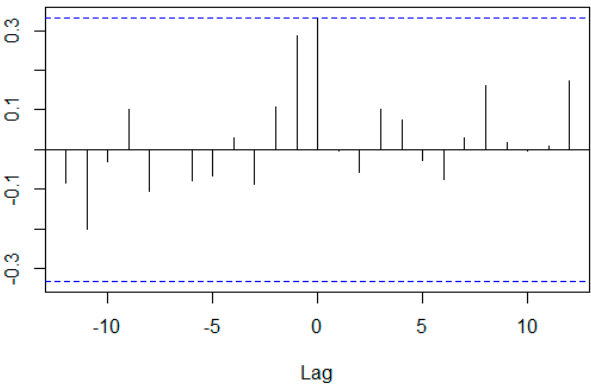
Figure 8. Cross-correlation coefficient between the average CAR of the camera group and the average CAR of the display group for Evaluation period: the month in which each company was listed - 2008, Event period: 2010–2012.